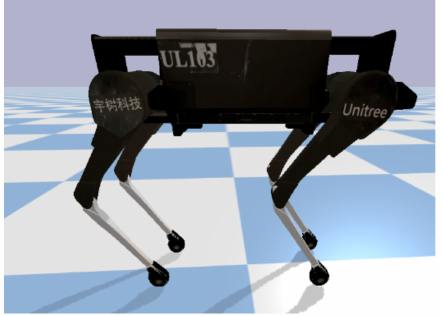
Figure 9. Laikago’s model.